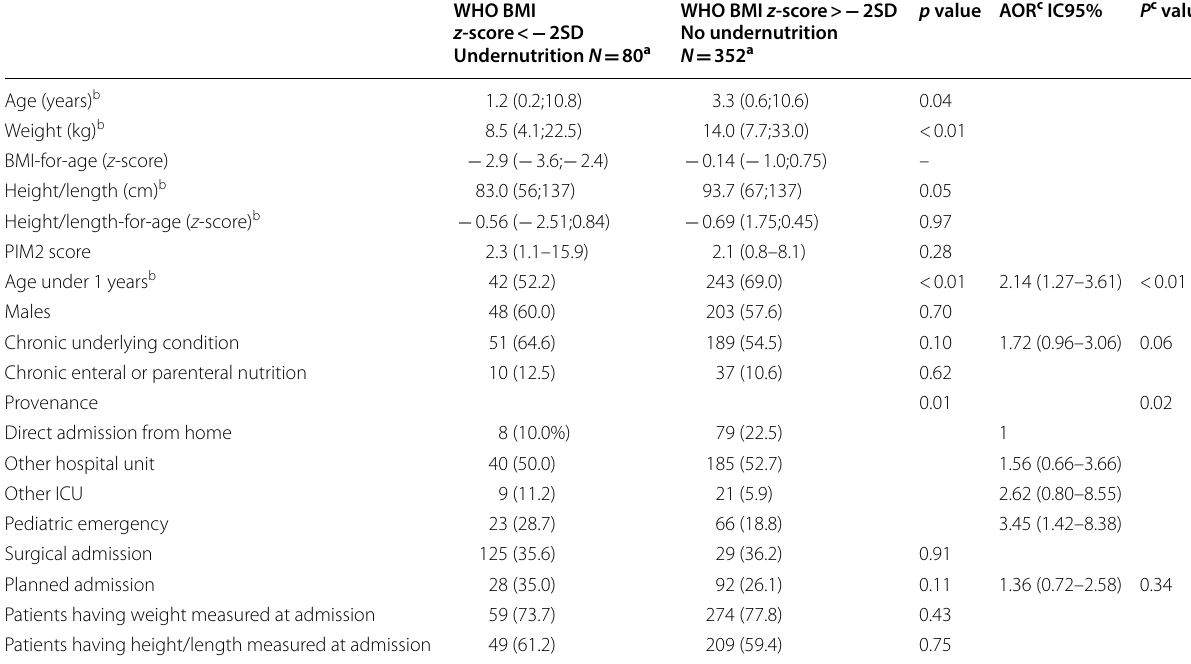
Data are presented as medians ( Q 1– Q 3) or as N